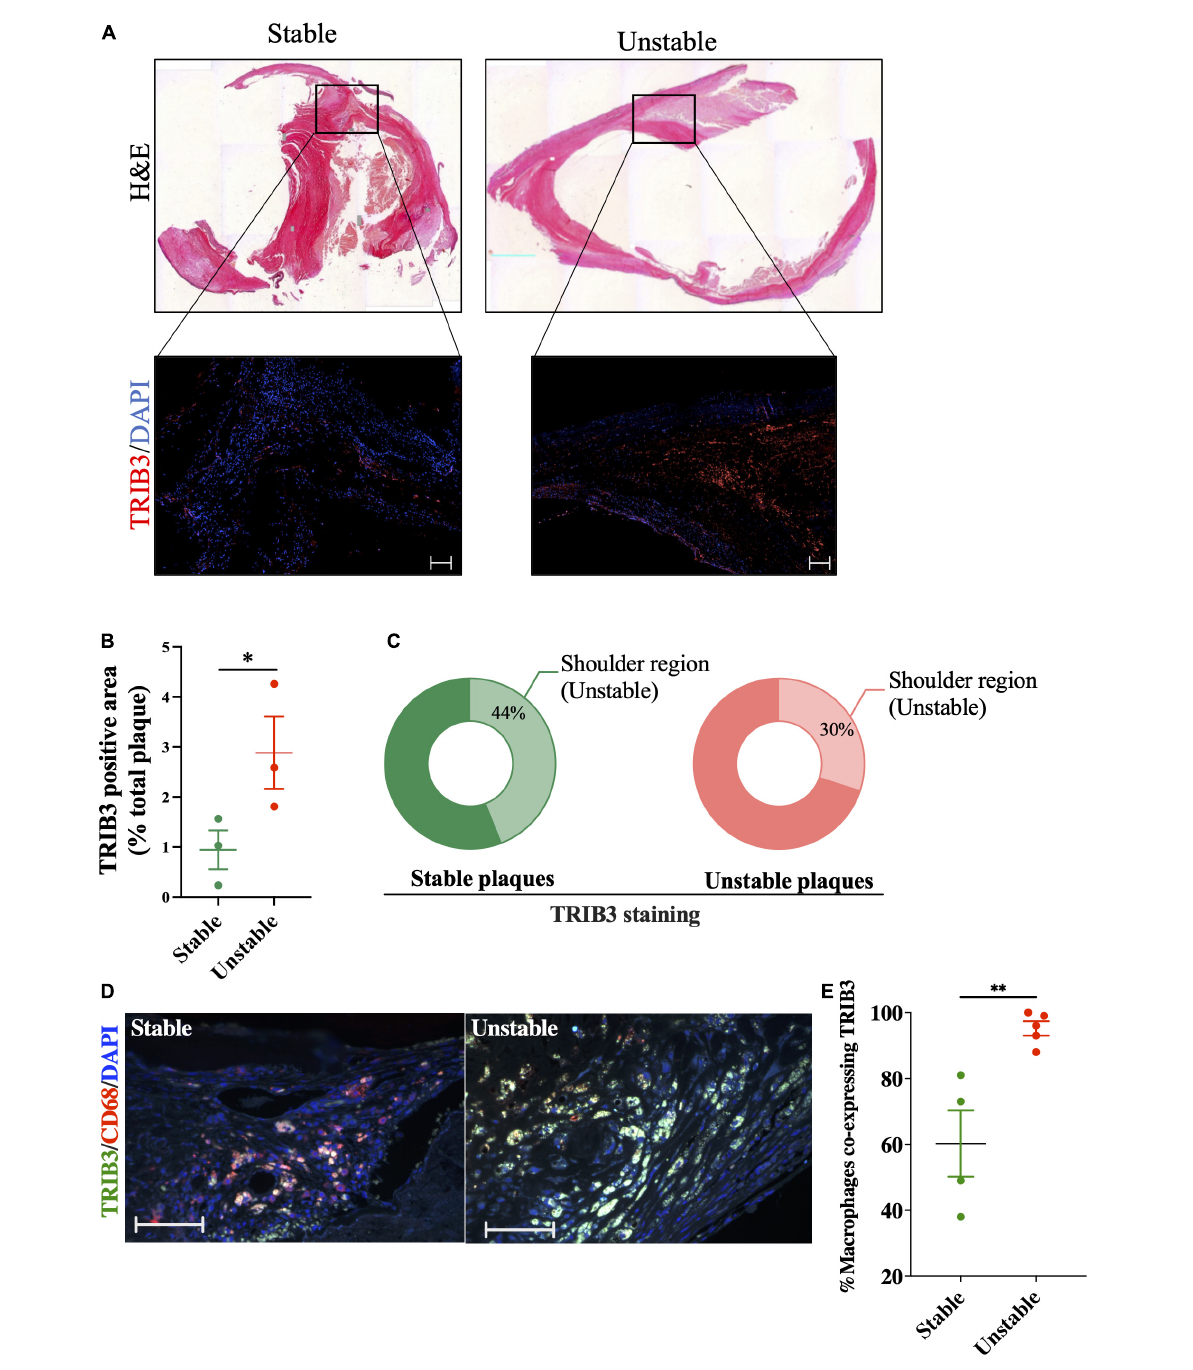
FIGURE1 TRIB3 expression is increased in human unstable carotid plaques, in unstable plaque regions and in macrophages from unstable plaques, relative to stable plaques. (A) H&E staining of human carotid plaques was used to identify plaque features, classified as stable or unstable using the Stary classification guidelines. Below, representative images of the shoulder region of these plaques with TRIB3 staining (red) with DAPI (blue) as a nuclear marker (scale bars represent 100 µ m). (B) Quantification of TRIB3 expression, as a percentage of the plaque area, of stable (0.944 ± 0.38) and unstable (2.88 ± 0.72) plaques. (C) Percentage of the total TRIB3 staining in the shoulder region (stable: 43.71 ± 9%; Unstable: 56 ± 9%). (D) Representative images of TRIB3 and CD68 macrophage co-staining from stable and unstable plaques (scale bars represent 100 µ m). (E) Quantification of percentage CD68 + macrophages co-expressing TRIB3 in stable and unstable plaques. Data is shown as the mean ± SEM; each data point represents one donor ( N = 3–5 patients). Unpaired t -test, ∗ p < 0.05, ∗∗ p <